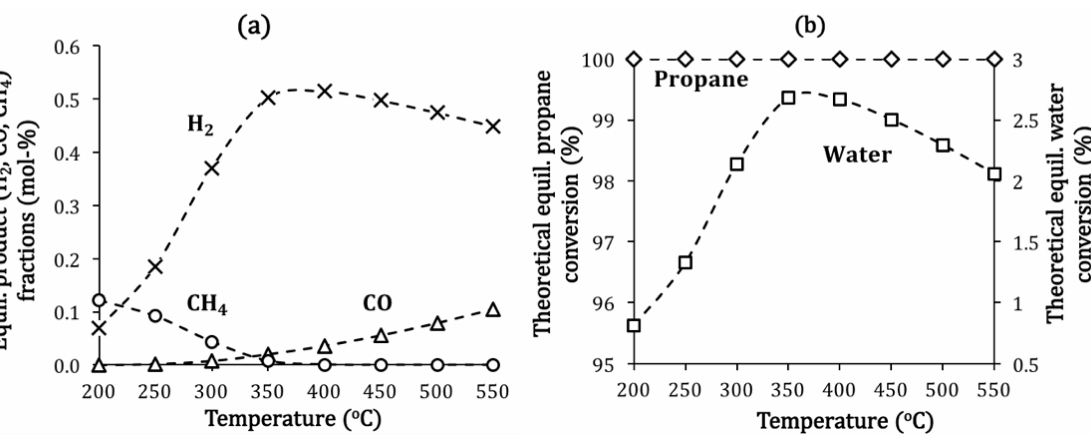
Figure 4. Reaction Gibbs free energy as a function of reaction temperature (25 °C to 700 °C) at 1 atm. Assume ideal gas behavior for the reactant and product gas components. Compound thermodynamic data with temperature and pressure inputs is collected from I. Barin, Thermochemical Data of Pure Substances (3rd Edition) [48].